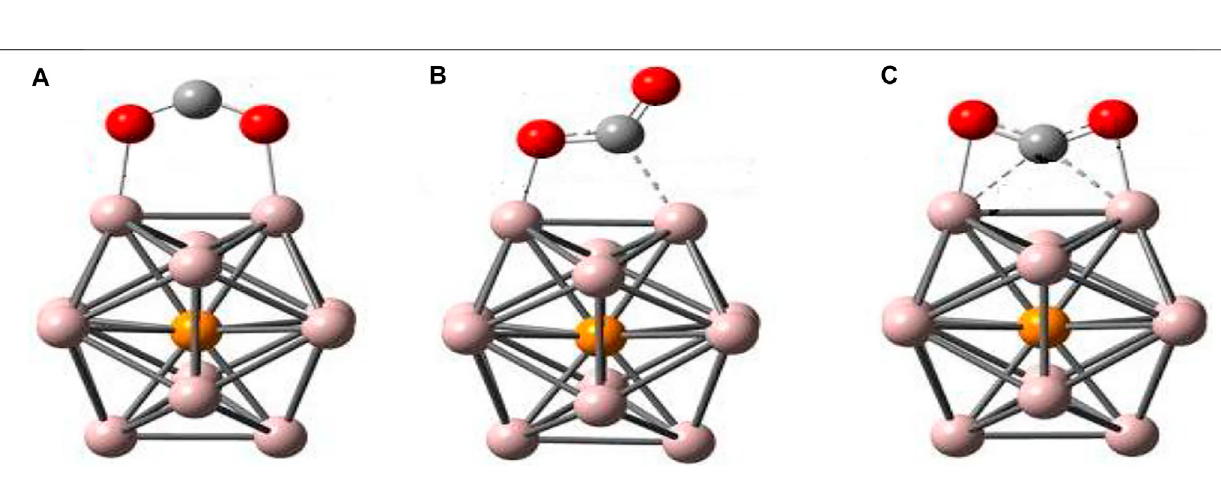
Frontiers in Physics |